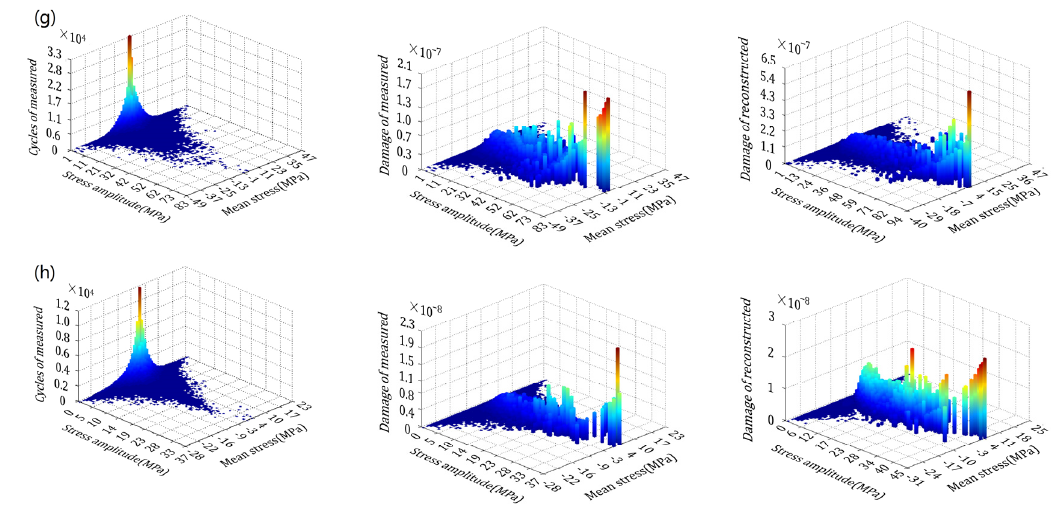
Figure 15. Measured cycles and damage graphs of capture and reconstruction stress. ( a ) Air spring